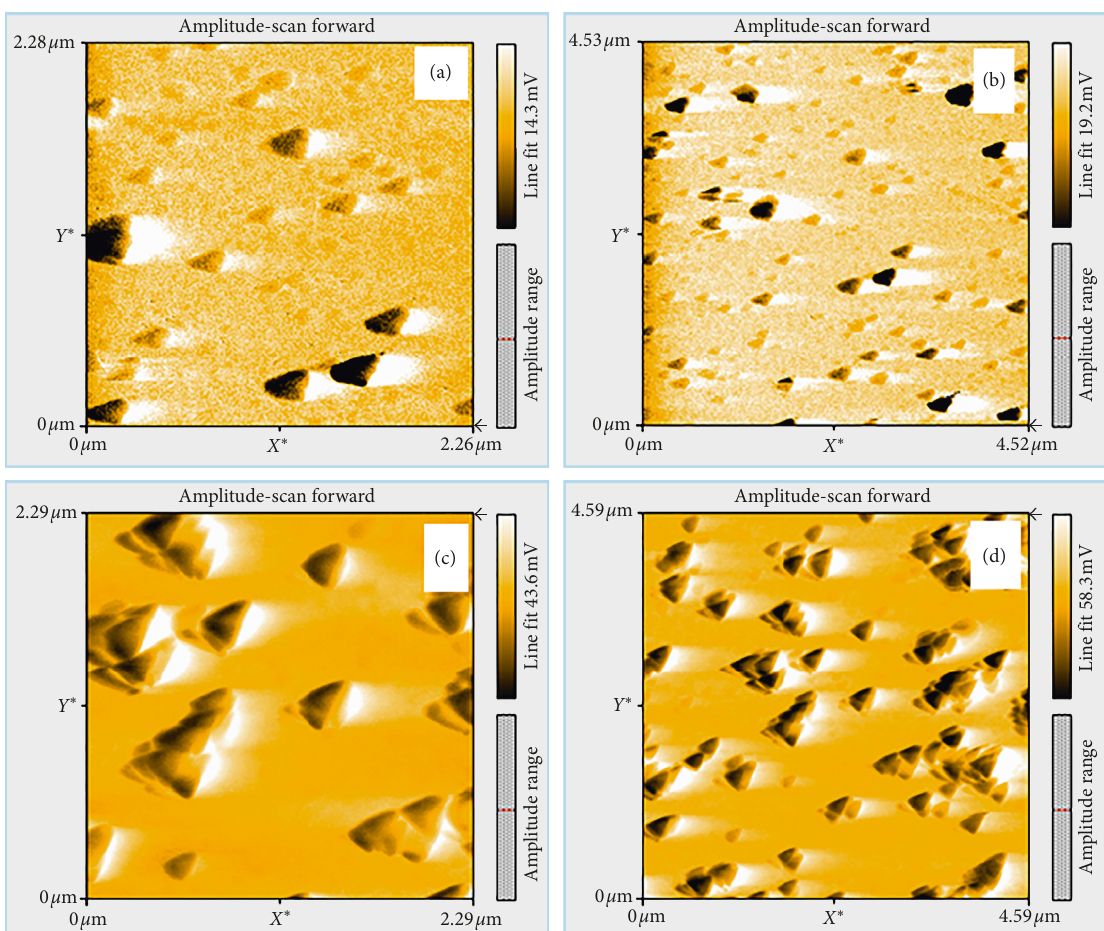
Figure 10: AFM images for n-Au before (a, b) and after treatment with β -carotene (c,